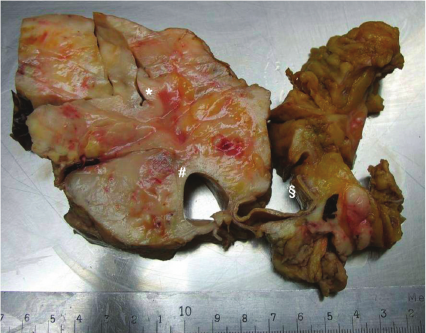
Figure 1: Orolabial vesicles and ulcers. Appearance of orolabial vesicles and ulcers on day 17 of ICU treatment, two days before death (percutaneous tracheotomy was performed on day 7).